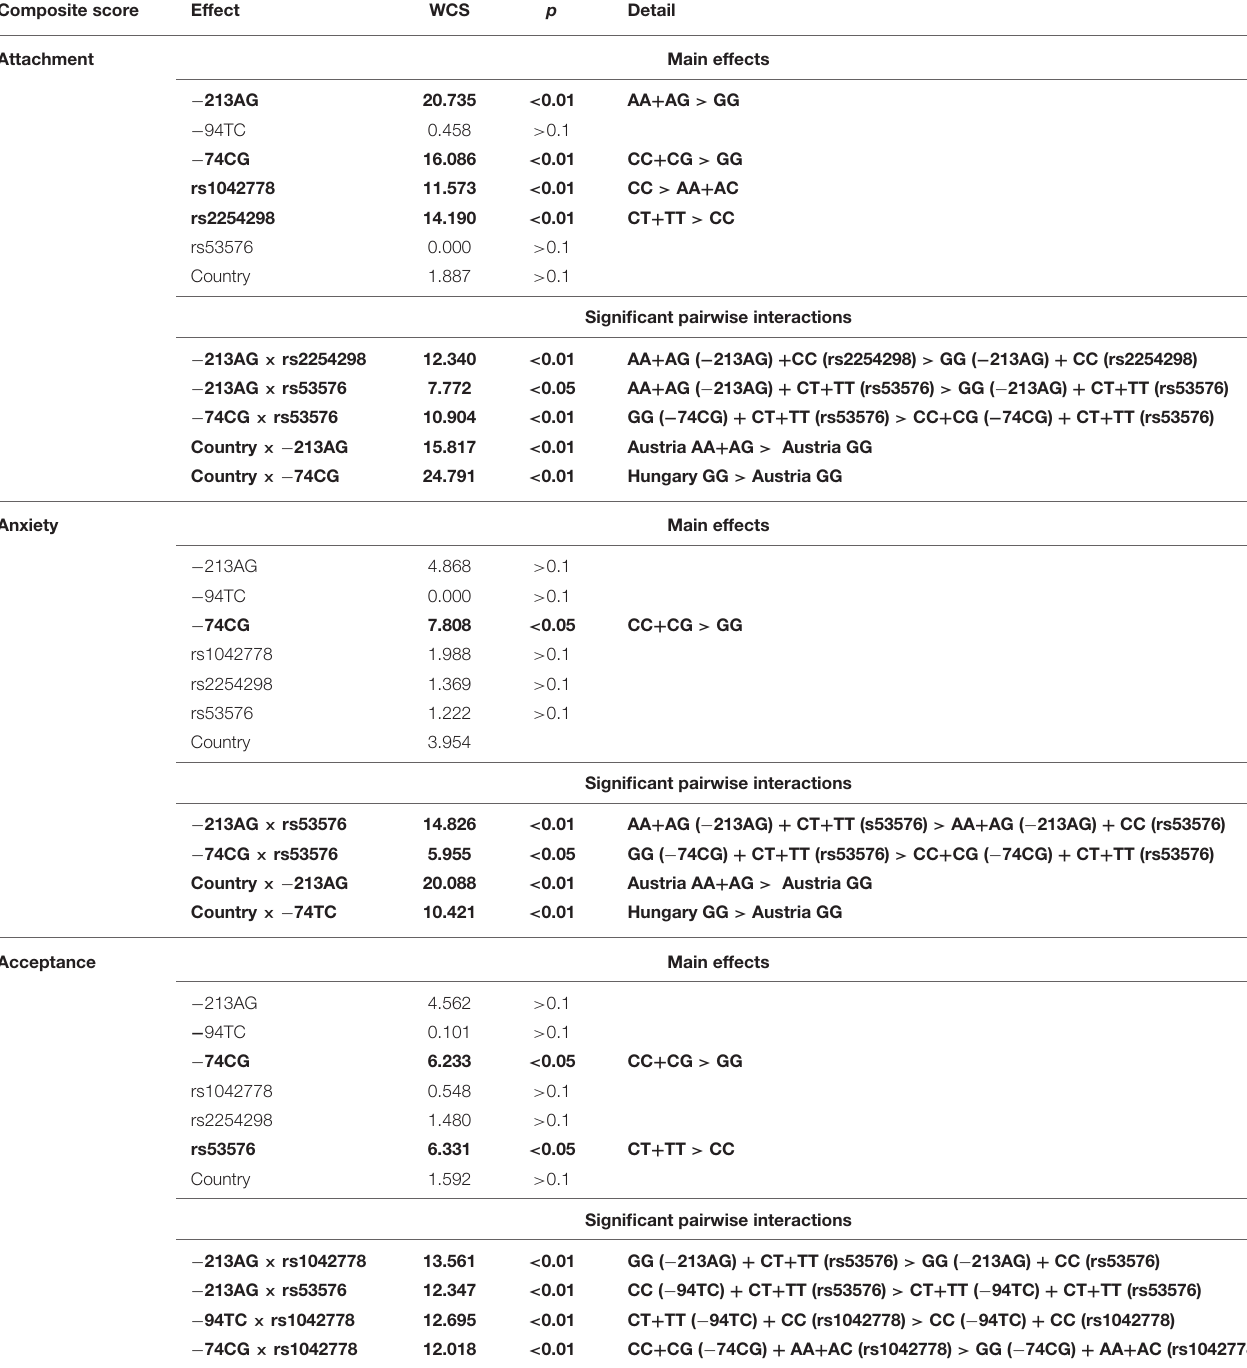
TABLE 4 | Summary of the effects of dog and owner OXTR polymorphisms on dogs’ Attachment, Anxiety, and Acceptance composite scores as measured in the Strange Situation Test. Composite